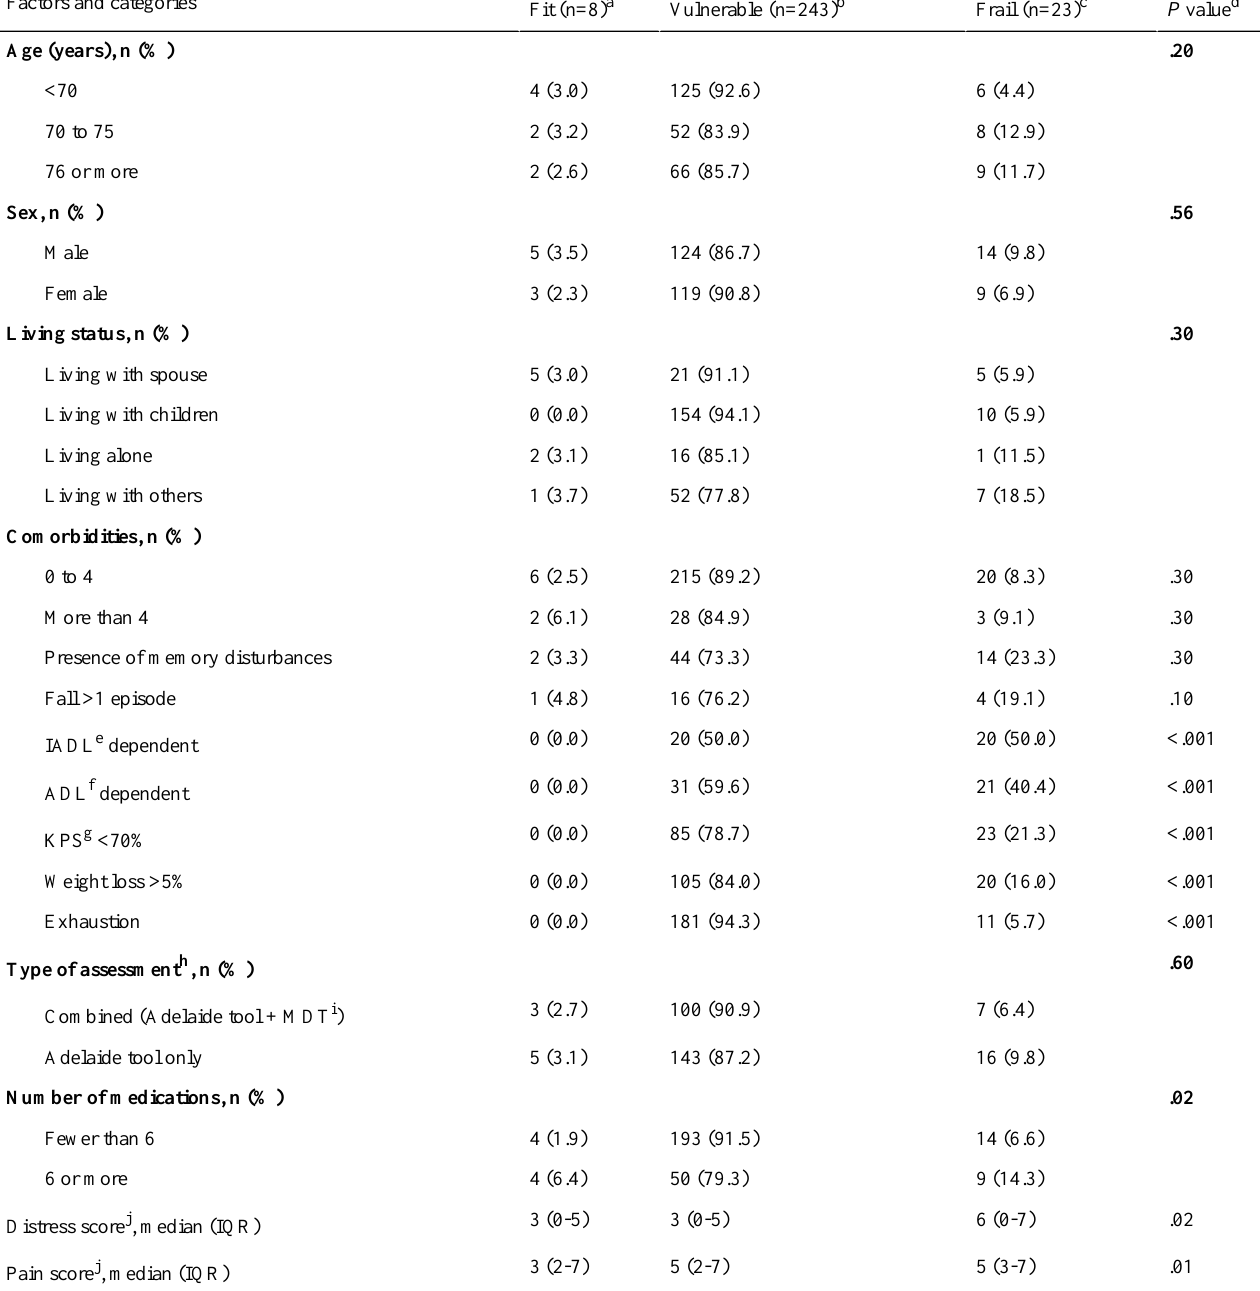
Table 3. Distribution of functional status across sociodemographic and clinical characteristics